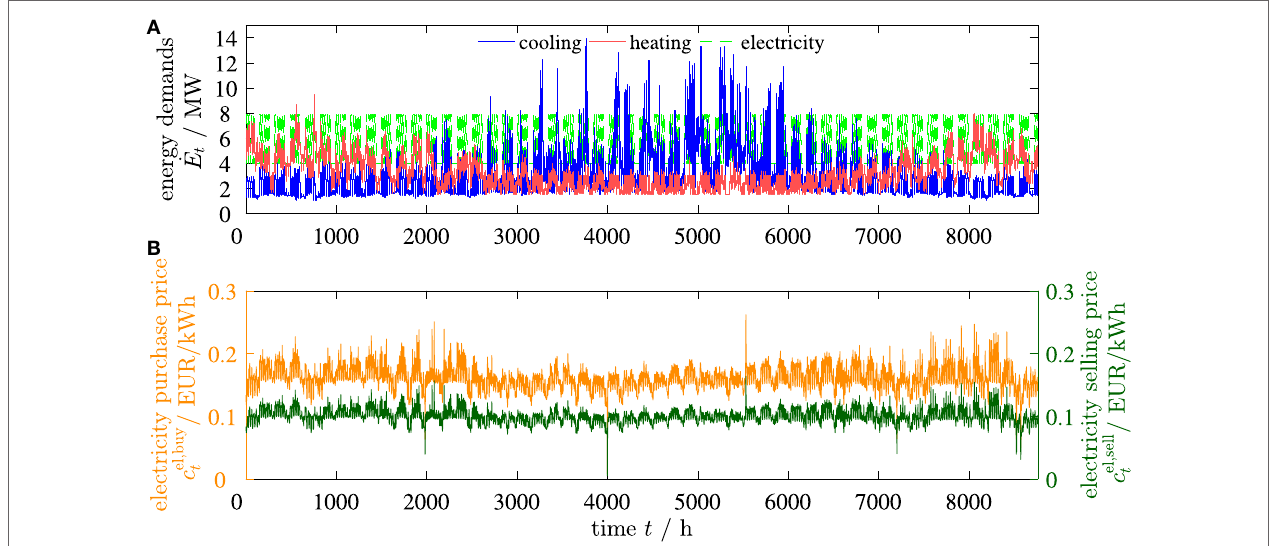
FIGURE 5 | Time series T S of the original instance for (A) heating, cooling, and electricity demands, and (B) electricity purchase and selling price over 1year with a resolution of 1h.